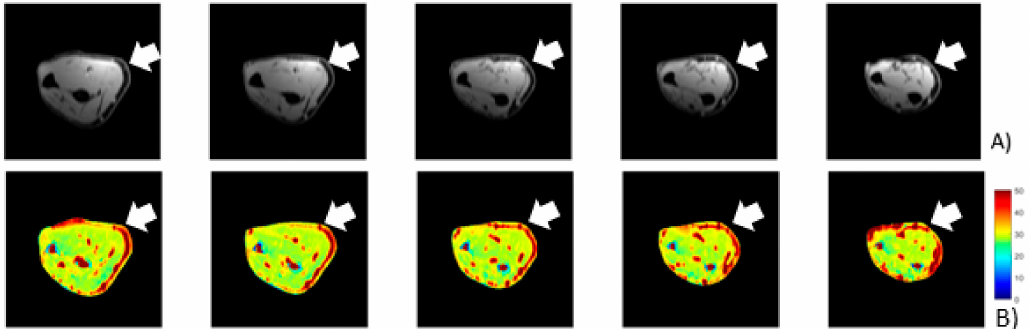
Figure 4. ( A ) Pretreatment of T1 MRI where the thickness of the brachial fascia is evident. The fascia is the black ring below the skin identified by the arrow. ( B ) Pretreatment T 1 (cid:37) -mapping where the higher concentration of unbounded water is evident (water that it is not linked with any glycosaminoglycan or hyaluronan) within the brachial fascia in the symptomatic side (white arrow). Most of the patients presented a statistically significant di ff erence in T 1 (cid:37) relaxation time between